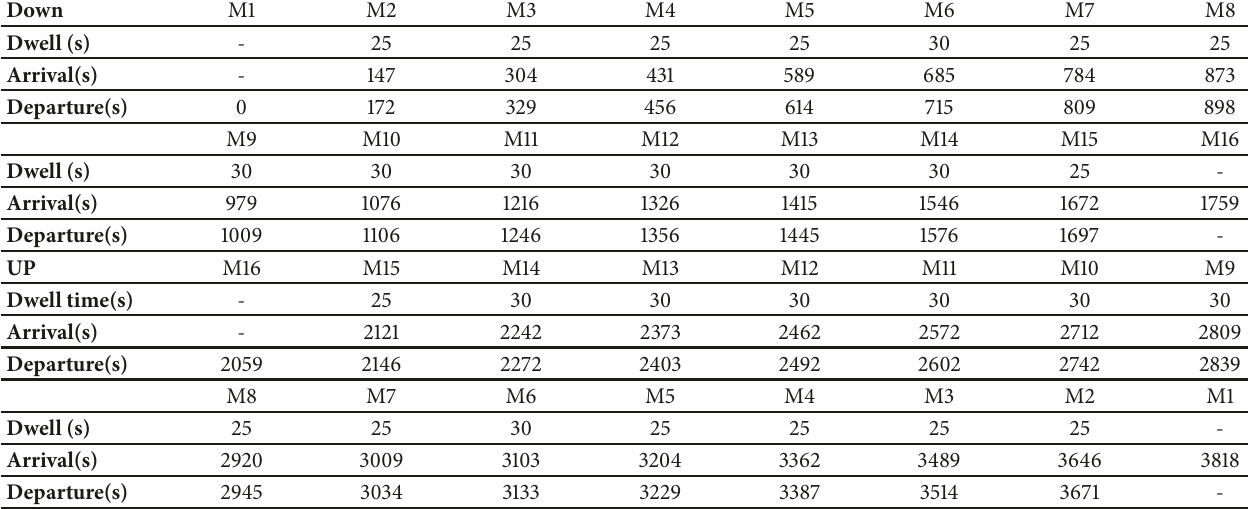
Table 6: The optimized timetable of